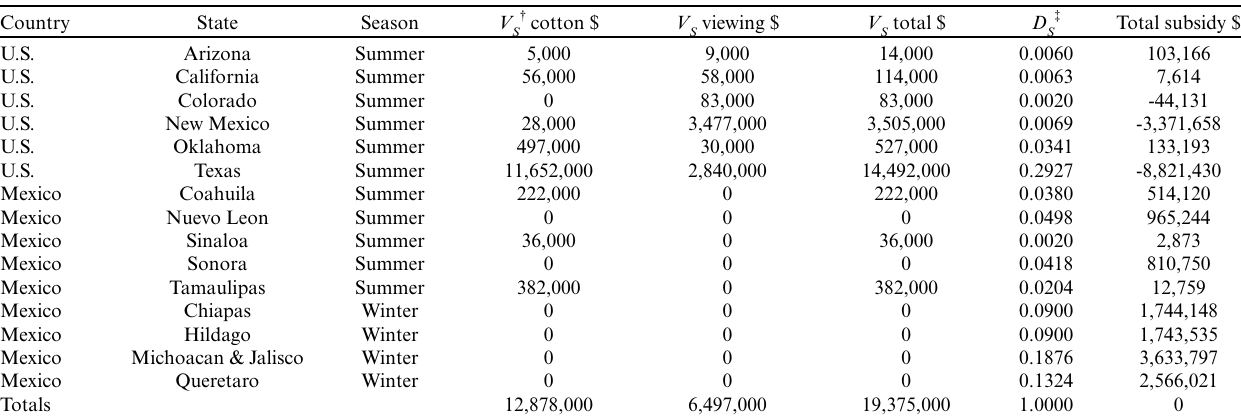
Table 1 . Spatial subsidy calculations for the Mexican free-tailed bats summed by state. Note that several states have more than one bat breeding roost. Currency is expressed in 2011 U.S. dollars.